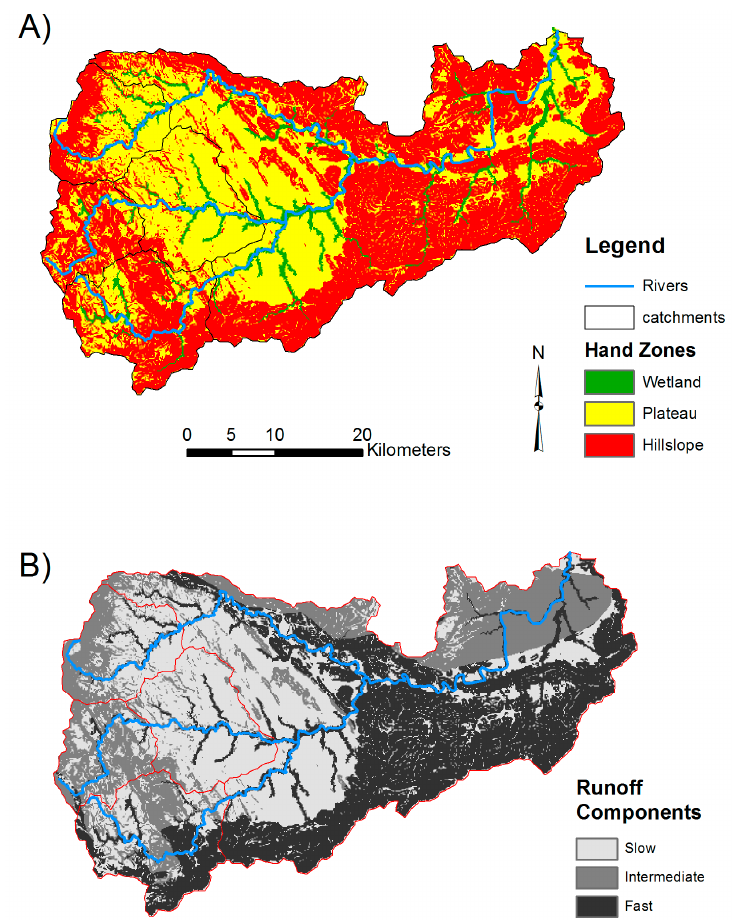
Figure 2. ( A ) HAND zones delineated based on combinations of the HAND value and slope maps; ( B ) Dominant runoff zones, defined based on combination of HAND zones and underlying geology.